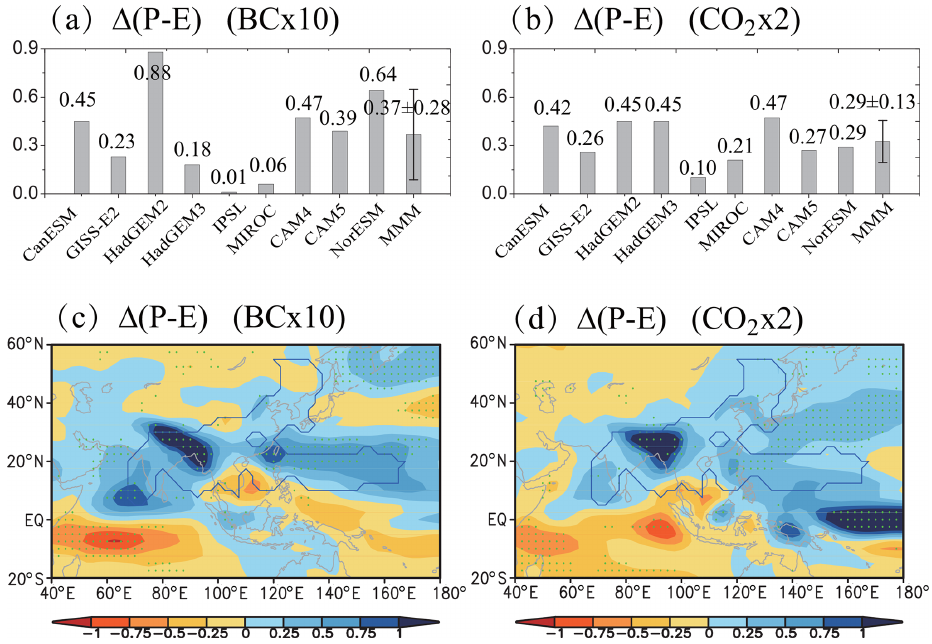
Figure 4. Changes in the MJJAS precipitation minus evaporation ( (cid:49) ( P − E ); unit: mmd − 1 ) under (a, c) increasing BC and (b, d) GHGs. (a, b) Domain-averaged value over the Asian monsoon region and (c, d) spatial pattern of the multimodel mean (MMM). Error bars (a, b) of the MMM represent the standard deviation. Dotted regions (c, d) indicate where the MMM is more than 1 standard deviation away from 0. The areas within the blue line represent the Asian monsoon